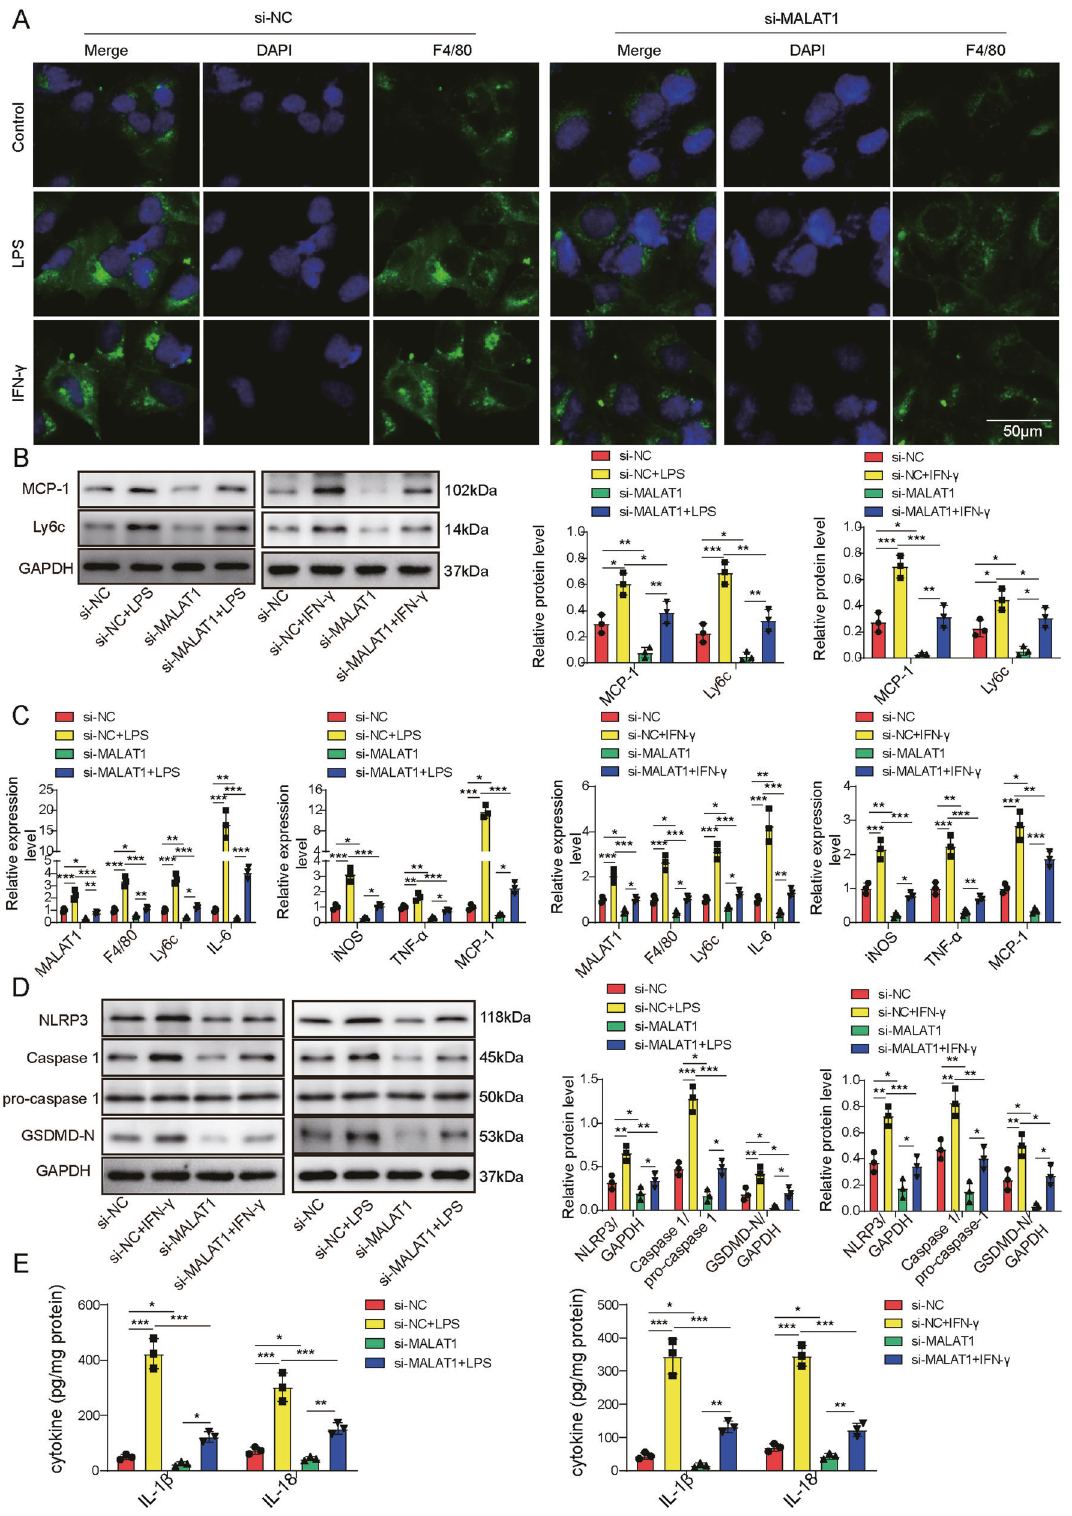
Fig. 3 Targeting MALAT1 dampened in fl ammation and NLRP3 in fl ammasome-induced pyroptosis in M1 macrophages. Isolated KCs were transfected with siNC or siMALAT1 and treated with PBS (control), LPS, or IFN- γ . A F4/80 expression in indicated cells was examined by immuno fl uorescence (green). Cell nuclei were stained with DAPI (blue). Expressions of F4/80 and Ly6c proteins were detected by western blot ( B ), of MALAT1, F4/80, Ly6c, IL-6, iNOS, TNF- α , and MCP-1 by RT-qPCR ( C ), and of pyroptosis-related markers, NLRP3, pro-caspase-1, Caspase-1, and GSDMD-N by western blot ( D ) from indicated cells. E The productions of IL-1 β and IL-18 in supernatants of indicated cells were measured by ELISA. * P < 0.05, ** P < 0.01, *** P < 0.001.